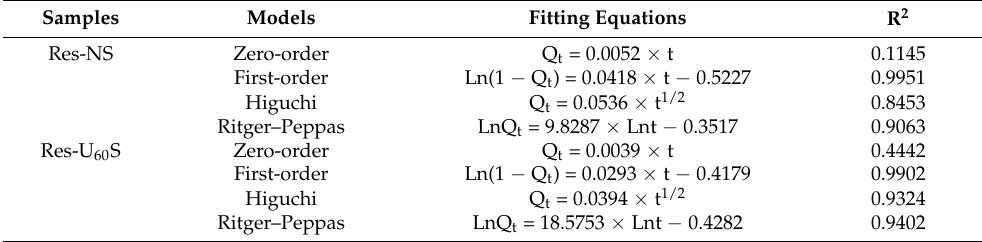
Table 4. Fitting results of the kinetic-release model of resveratrol from Res-NS and Res-U 60 S.